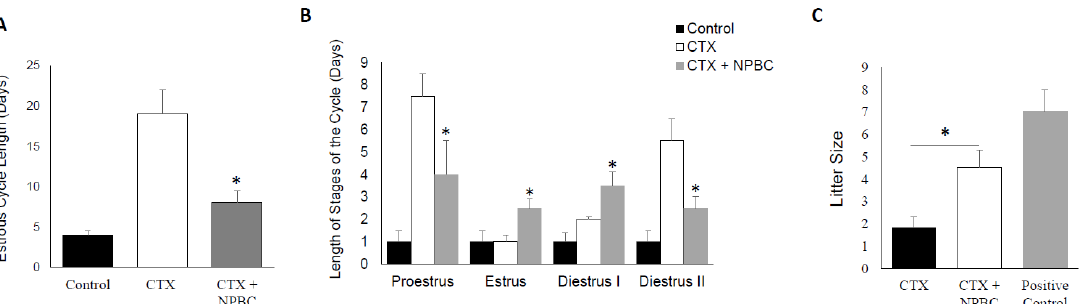
Figure 6. Impact on nucleated peripheral blood cells on estrus cycle and fertility. ( A ) Estrous cycle length presented in days comparing CTX to CTX treated with PBMC versus matched negative control (* p < 0.05); ( B ) length of estrus cycle stages presented in days of the three involved mice groups: Control, CTX and CTX treated with PBMC (Peripheral blood mononucleated cells) (* p < 0.05); ( C ) effect of PBMC on fertility presented in litter size compared between CTX to CTX treated with PBMC versus matched negative control (* p < 0.05).